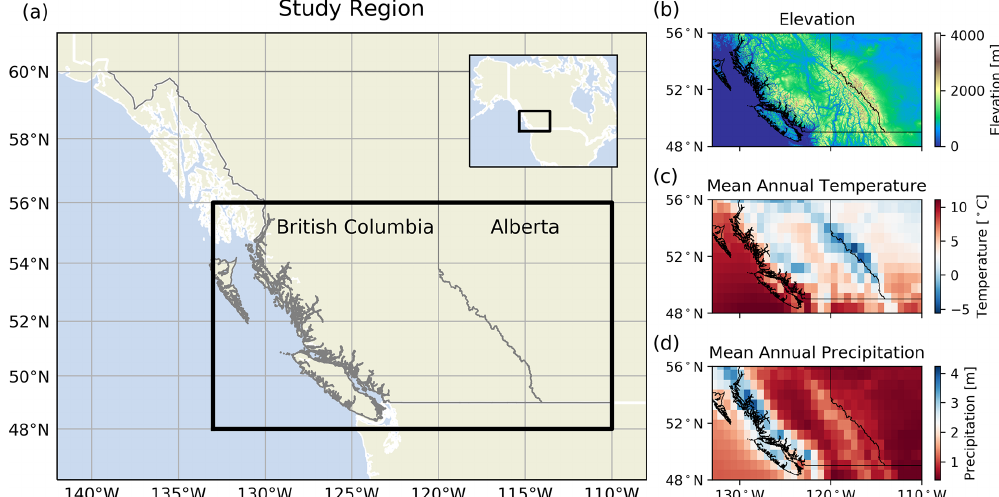
Figure 1. The study region in western Canada. (a) The black box outlines the study region in both the main figure and the inset. The provincial borders of British Columbia and Alberta are shown in grey. The inset shows the broader context of the study region in North America. The figure is made with the Python library Cartopy (Met Office, 2018) and with data from Natural Earth. (b) Elevation data of the study region are from the Shuttle Radar Topography Mission (Farr et al., 2007). (c) Mean annual temperature and (d) mean annual precipitation, as calculated over the study period (1979–2015), from ERA5 climate reanalysis (Hersbach et al.,